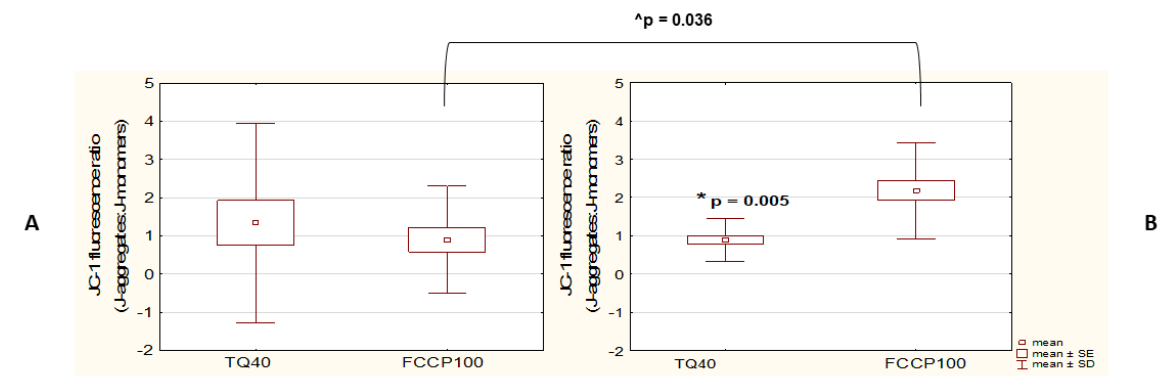
Figure 6. WM9 cell line shows higher sensitivity to 40 µ M TQ than to FCCP. Spectrofluorometric assessment (JC-1) of the mitochondrial membrane potential ( ∆Ψ m ) in A375 ( A ) and WM9 ( B ) cells treated with 40 μ M TQ for 48 h, or with 100 μ M FCCP, for 4 h. * denotes a significant decrease in ∆Ψ m compared to FCCP control; ^ denotes significant differences between the two analyzed cell lines; data are presented as mean ± SD; p < 0.05 was considered to be statistically significant (Mann–Whitney U test).